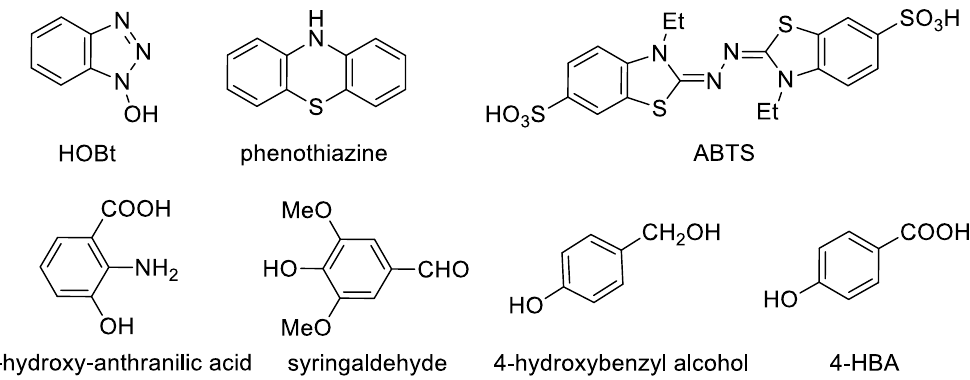
Figure 1. Representative synthetic (upper row) and natural (lower row) laccase mediators (based on [22,24]).